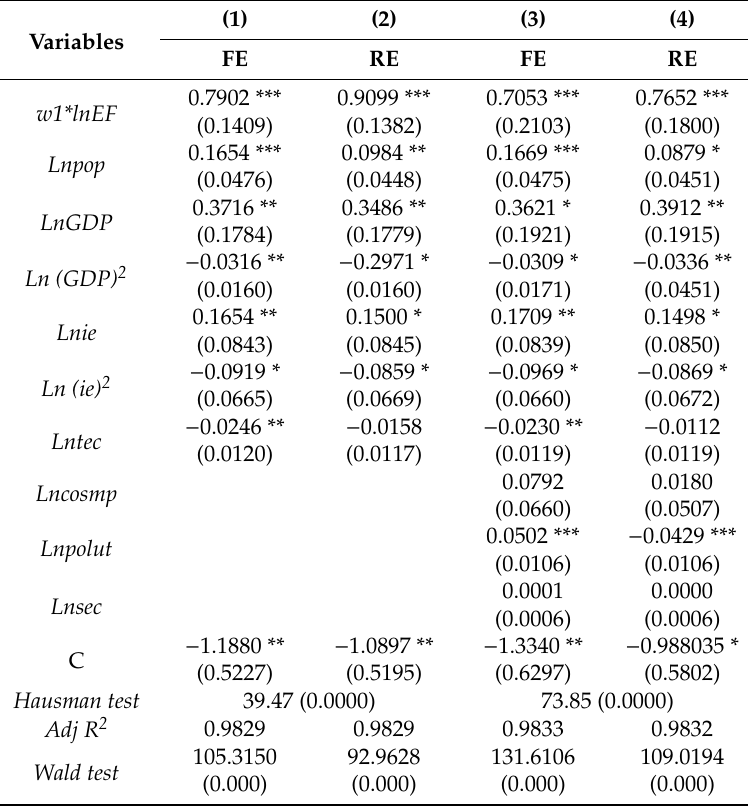
Table 2. Benchmark regression